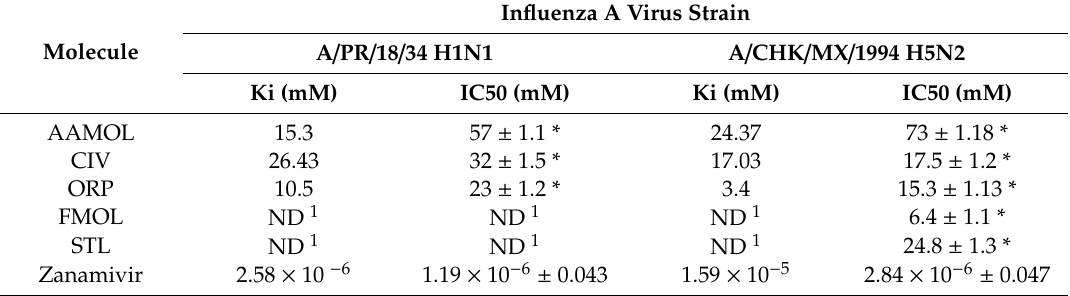
Table 1. Inhibition constant (K i ) and half maximal inhibitory concentration (IC 50 ) of molecules against influenza A virus strain. For the FMOL and STL molecules, only the IC 50 with the avian subtype H5N2 was determined. Influenza A Virus Strain Molecule A / PR / 18 / 34 H1N1 A / CHK / MX / 1994 H5N2 Ki (mM) IC50